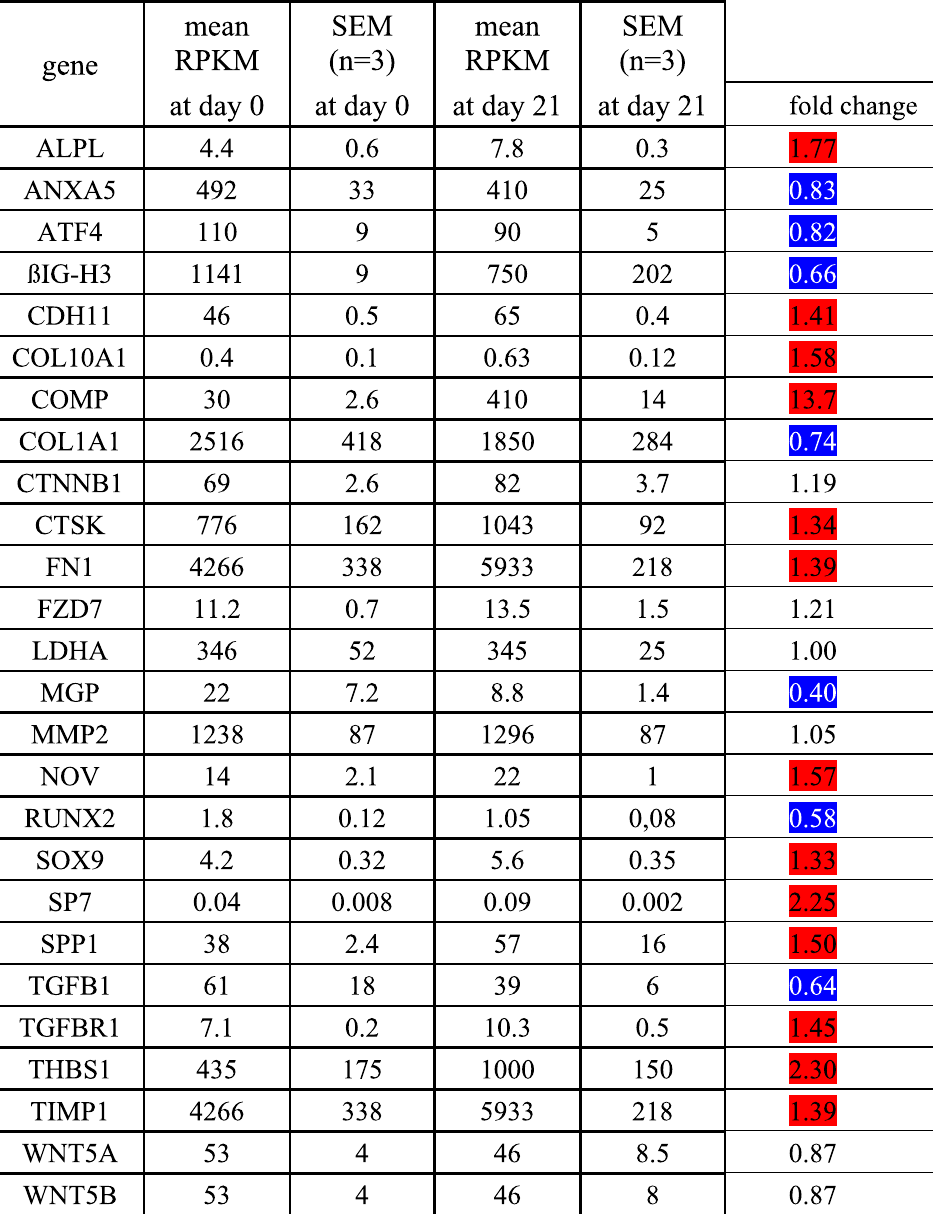
Table 1 mRNA-expression of osteogenic genes in human osteoblasts after 0 and 21 days cultivation. Significant increase ( p < 0.05) is given in red, significant reduction ( p < 0.05) is given in blue. mRNA expression of osteogenic genes in human primary osteoblasts at day 0 and 21 of cultivation. Shown is the mean RPKM independent